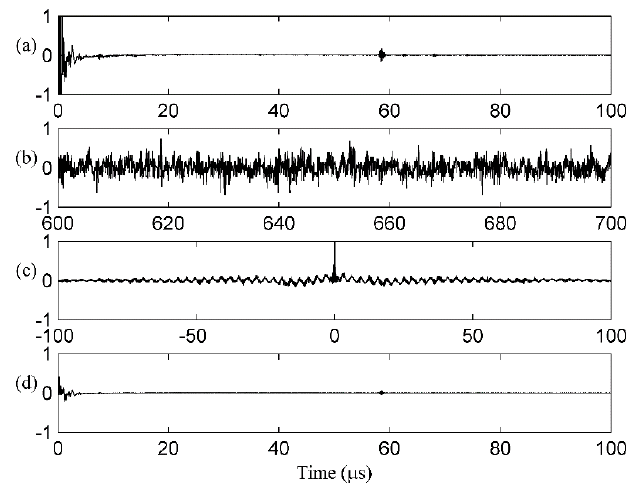
Figure 6. Time traces for i = j = 16 in specimen 1: ( a ) Conventional full matrix; ( b ) diffuse full matrix; ( c ) Green’s function; ( d ) hybrid full matrix.